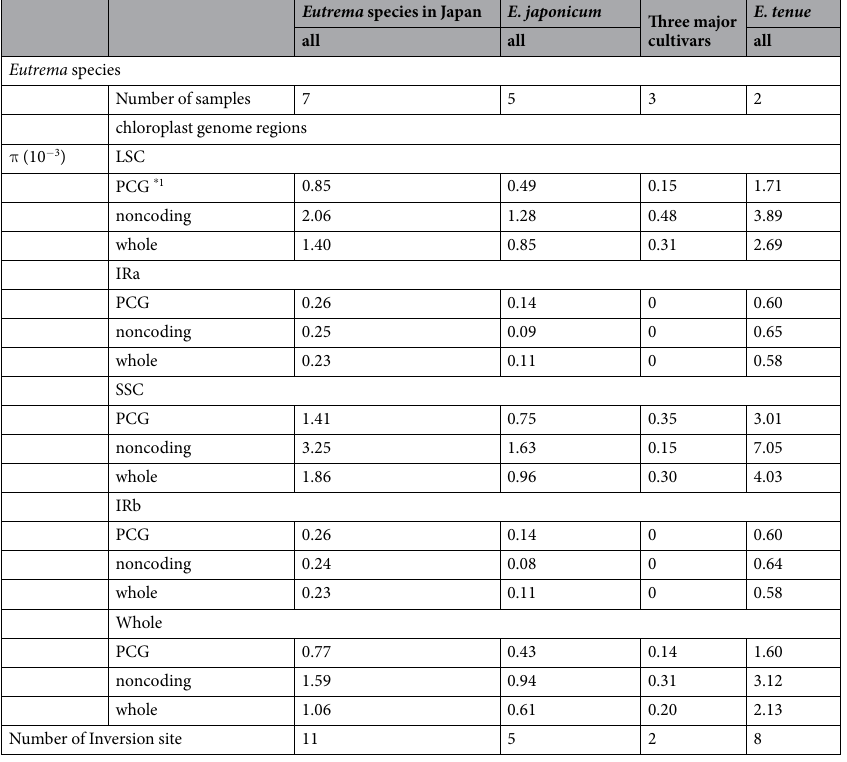
Table 1. Summary statistics of comparative whole chloroplast DNA sequences for Japanese. * 1 protein-coding genes.